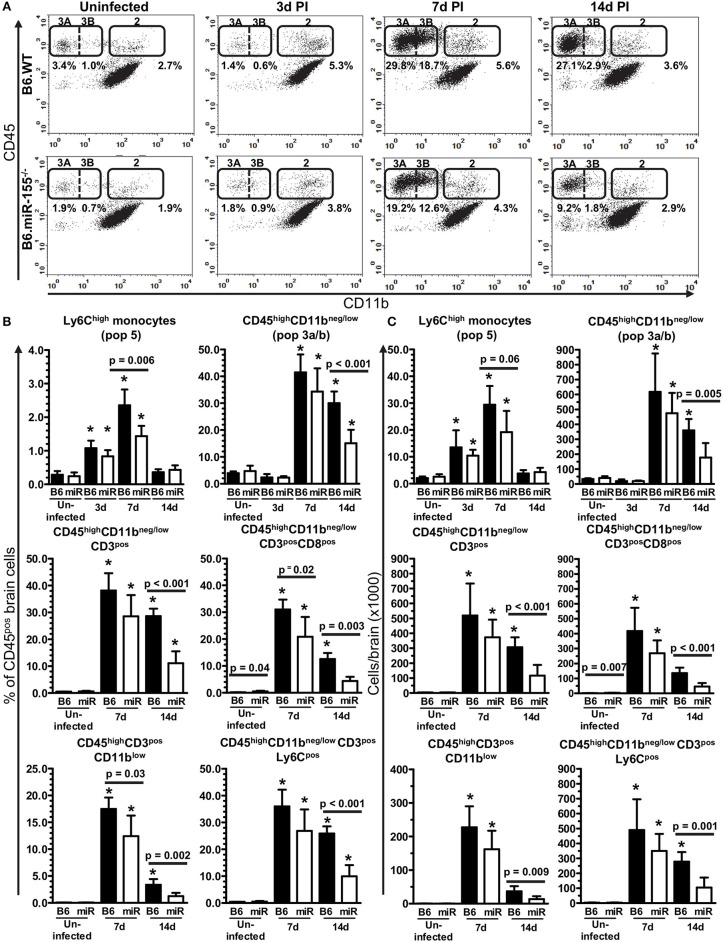
Lack of miR-155 impairs leukocyte recruitment to the brains of L. monocytogenes infected mice. Brain leukocytes were isolated from uninfected and infected age and sex-matched B6.WT and B6.miR-155−/− mice described in Figure 2A at the indicated times and analyzed by flow cytometry. (A) CD45pos cells were gated as in Figures 4A,B, dotplots from representative B6.WT (upper panels) and B6.miR-155−/− (lower panels) animals are shown. Values given are gated events as a percentage of CD45pos cells. Results in (B,C) are the mean + SD % CD45pos cells (B), or cells/brain (C) from 4–9 B6.WT () or B6.miR-155−/− () mice/time point. *p < 0.05 compared with same genotype uninfected control by 1-way ANOVA with Dunnett's post-test. Significant p-values between genotypes calculated by 2-tailed Student's t-test are shown.